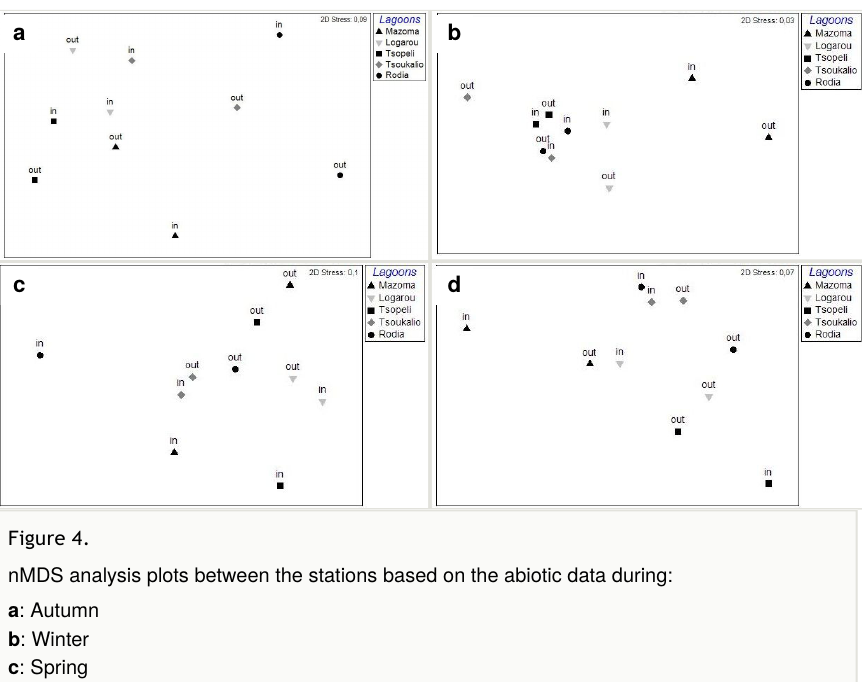
Applied on the same datasets, the PCA analysis revealed the fi rst two PCA axes ( λ >1) identi fi ed accounting for the 63.2% of the total variation in the autumn samples. The fi rst principal component was not found to be strongly associated with any of the variables. On the contrary, the second axis was associated (0.509) to the CPE of the sediment (Fig. 5a). For the winter samples the 73% of the variability was explained by the fi rst two axes ( λ >1) (Fig. 5b). The fi rst principal component was strongly correlated to the chl- a of the water column (-0.50), while the second component was strongly associated with the NO (-0.507). The 65% of the variability was expressed by the fi rst two components ( λ >1) in PCA from the spring stations (Fig. 5c). Nevertheless, only the fi rst one was found to be strongly associated to the following variables: the percentage of silt and clay (0.517) and the percentage of sand in the sediment (-0.517). In the PCA with the data from the summer sampling, only the fi rst two axes were found to ful fi ll the Kaiser-Guttman criterion and they described the 64.8% of the total variability. No variable was associated to the fi rst principal component, however, the second axis was characterized by the NH (-0.677) (Fig. 5d).